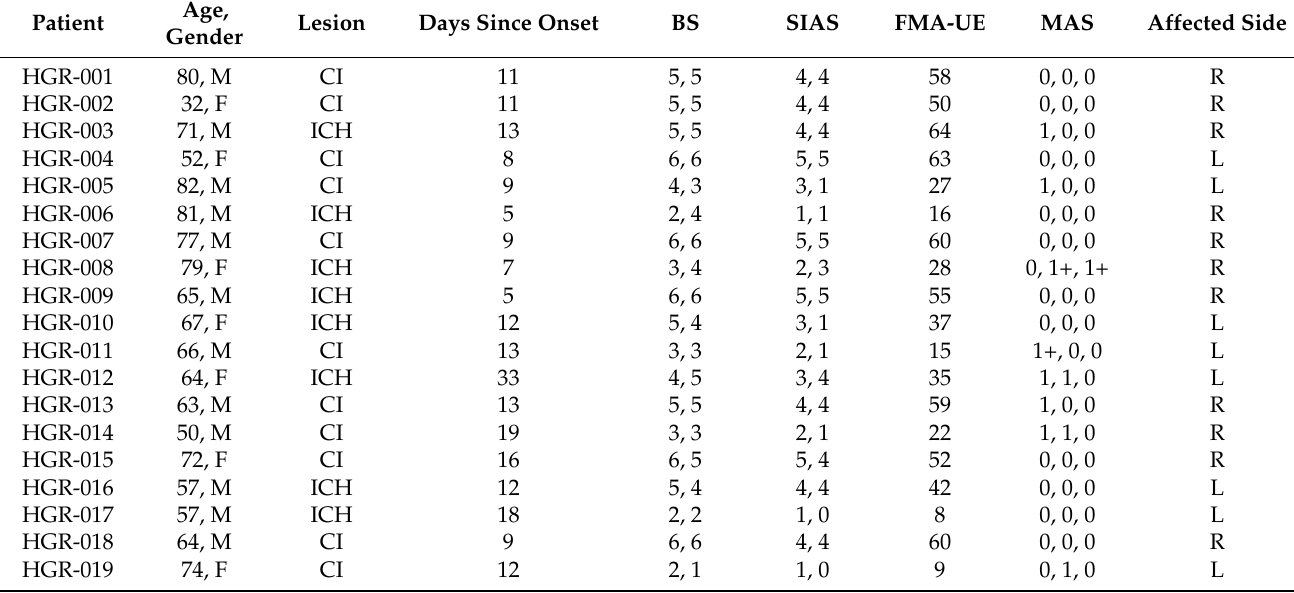
Table 4. Post-stroke patient demographics and BS, SIAS, and FMA-UE